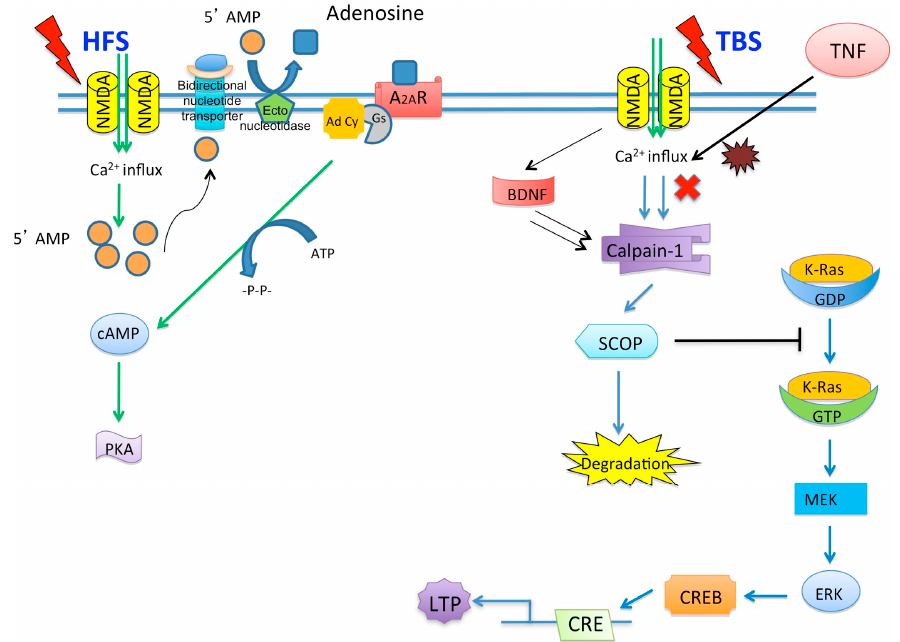
Figure 3. Putative signaling pathways activated after HFS- and TBS-induced LTP. HFS-induced